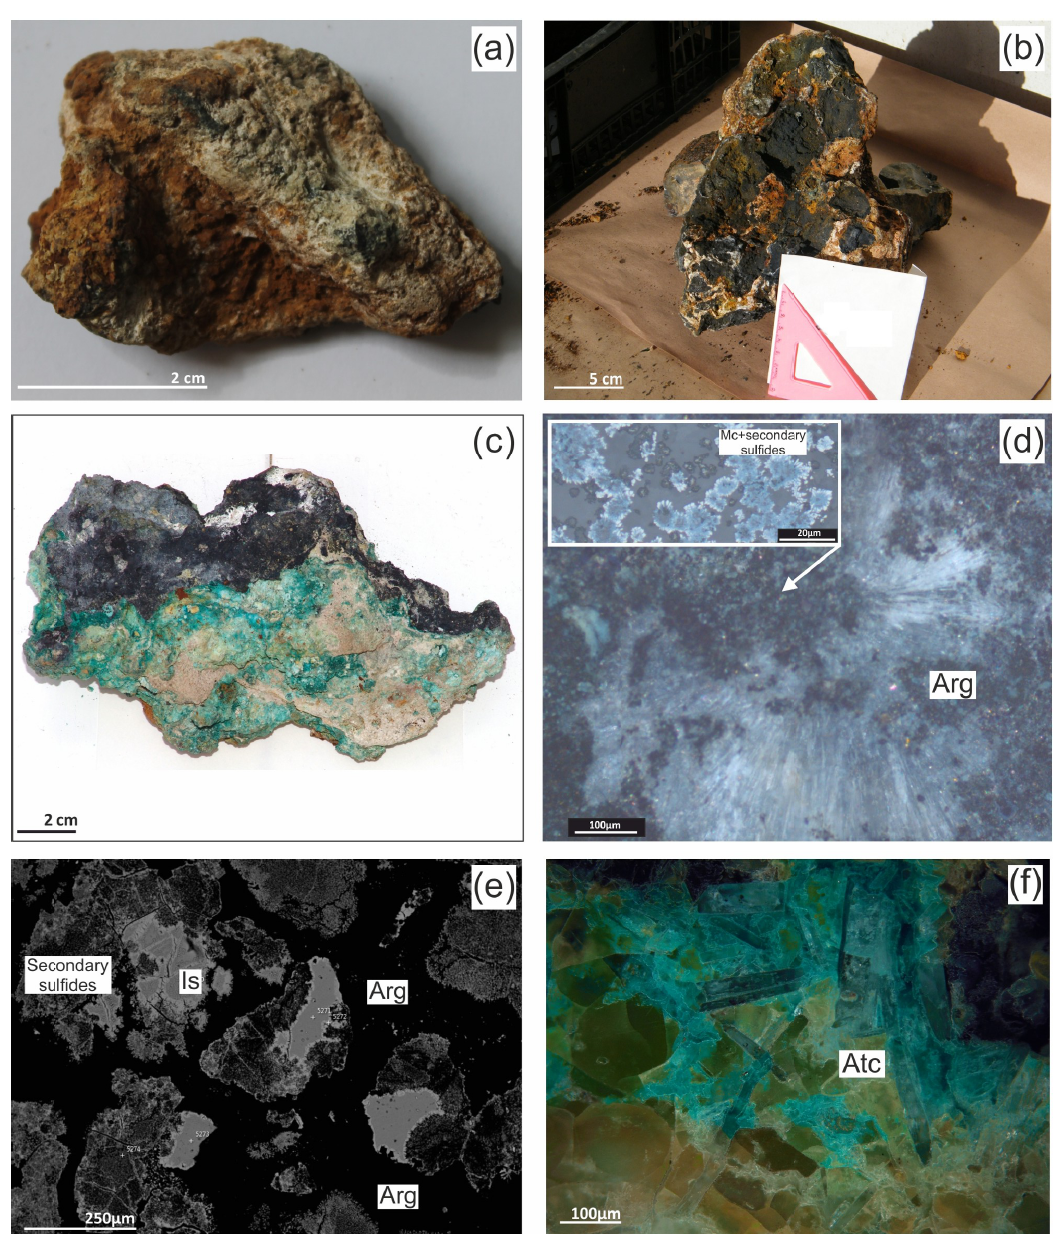
Figure 12. Altered sulphide breccia with aragonite cement. General view of samples ( a ) from 287 station; ( b ) from 240 station; ( c ) from 293 station; ( d ) Reflected light photographs; a fragment of massive chalcopyrite-sphalerite sulphide fully replaced by secondary copper sulphides in aragonite (Arg) in cement. Aragonite has radial crystals (287- Т- 1); ( e ) BSE photographs; clasts of isocubanite (Is) overgrown by Cu-sulphides of the covellite series in aragonite (Arg) (240); ( f ) Reflected light photographs; abundance of atacamite (Atc) in breccia from Station